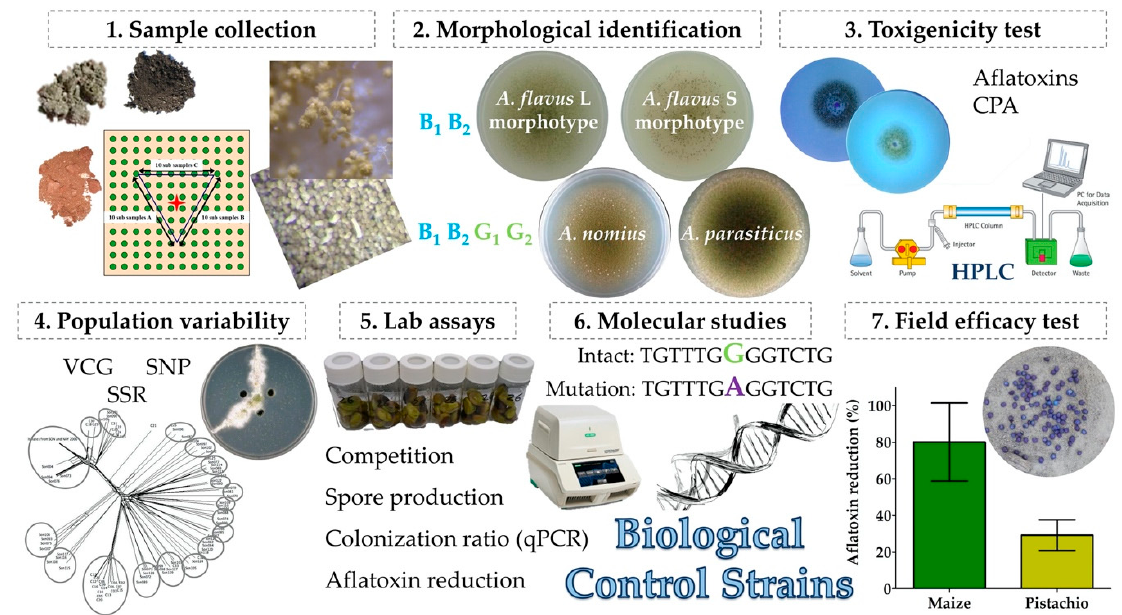
Figure 2. Illustration of the process to select atoxigenic isolates of Aspergillus flavus to develop aflatoxin biocontrol products.